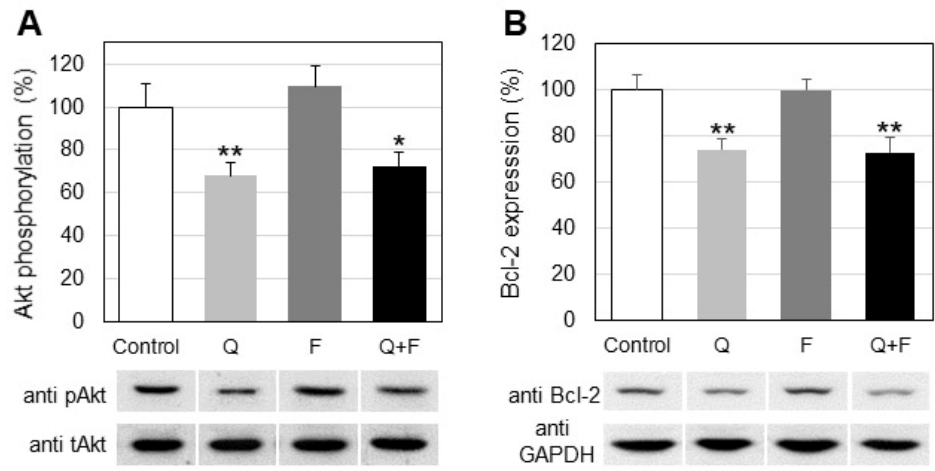
Figure 7. Changes in Akt phosphorylation ( A ) and Bcl-2 expression ( B ) in control and treated with quercetin (Q) and fingolimod (F) HepG2 cells. Values are expressed as % of controls. Representative images from Western blot analysis with specific antibodies to phosphorylated Akt (anti-pAkt) and B cell lymphoma 2 protein (anti-Bcl-2) are shown at the lowermost of the panels. Reactions with anti- bodies against total Akt (tAkt) and anti-glyceraldehyde-3-phosphate dehydrogenase antibodies (anti- GAPDH) were used as internal controls for loading. Values are means ± SD. Statistical significance is presented as comparison of treated cells with controls. * p < 0.05; ** p < 0.01.